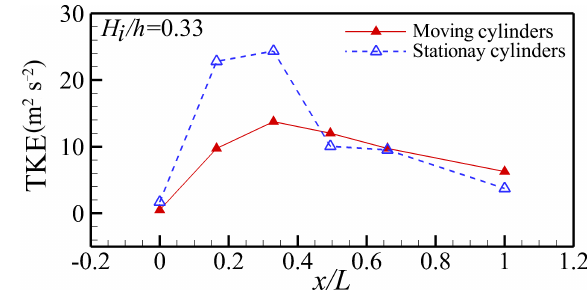
Figure 16. Comparison of total TKE evolution along cylinder array, H i =